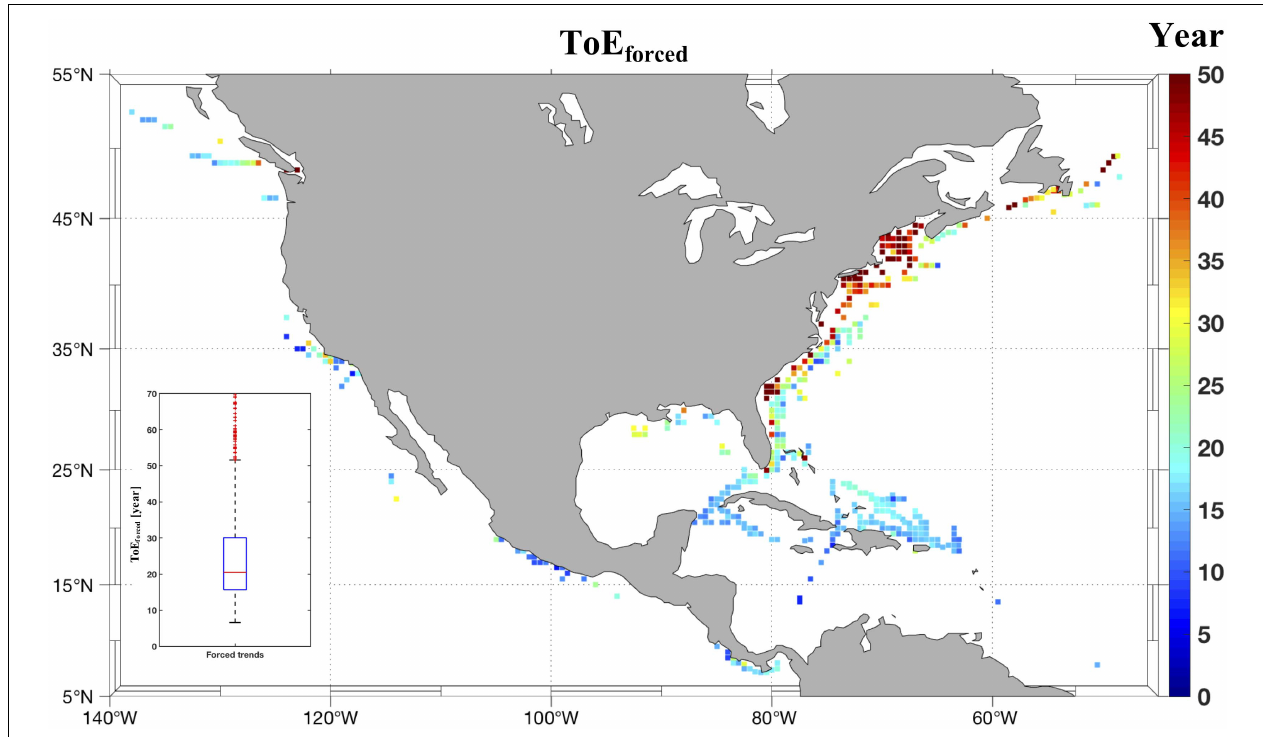
FIGURE 1 | ToE forced of ƒ(CO 2 , sw ) in the North American coastal margins. The inserted panel is the boxplot of ToE [the red line inside the blue rectangle (the interquartile range) represents the median, the “whiskers” above and below the rectangle show the minimum and maximum ToE values, and the red crosses are the